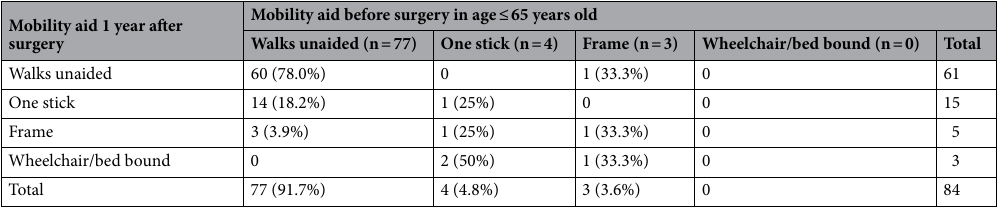
Mobility aid before surgery in age >